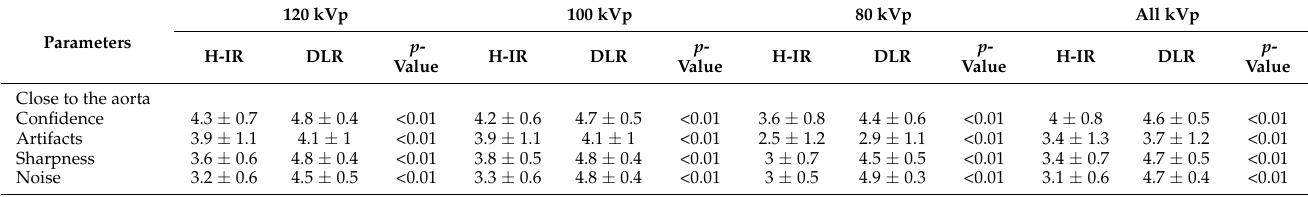
Table 7. Qualitative image evaluation including mean scores of confidence, artifacts, sharpness,